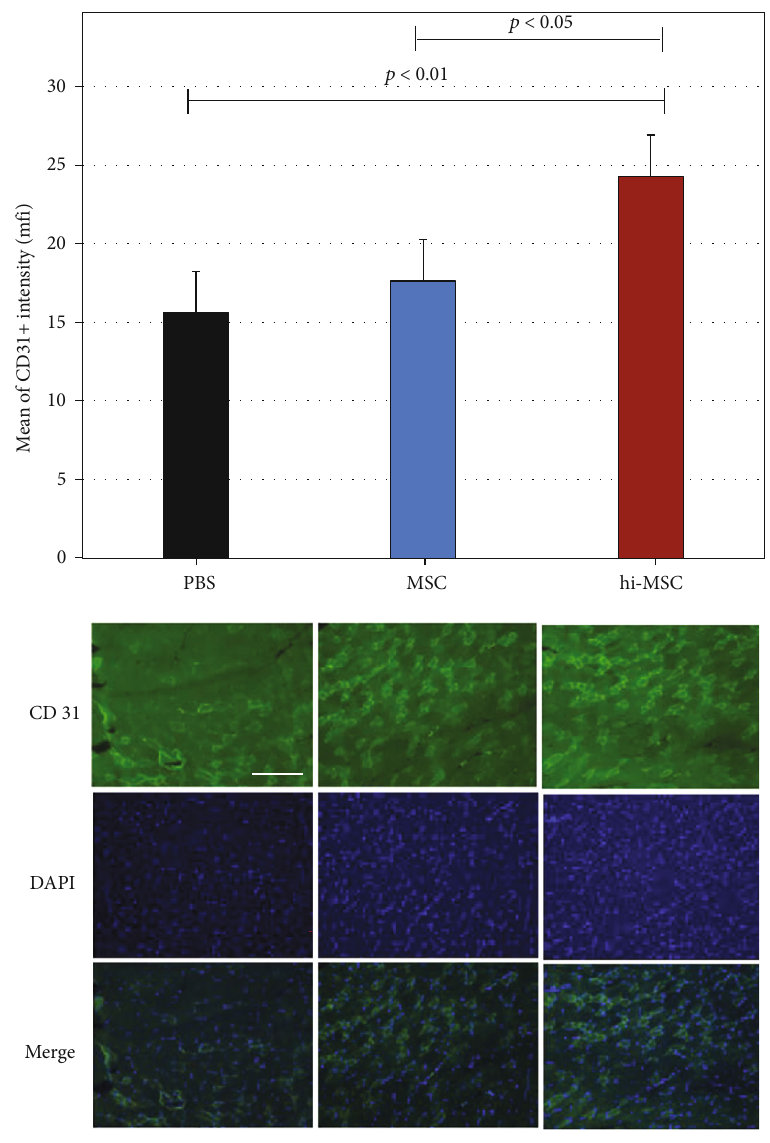
Figure 5: Mean cluster of di ff erentiation 31 (CD31) intensity at day 28 after surgical induction of ischemia. (a) Mean CD31 intensity in phosphate-bu ff ered saline (PBS; n = 6 ), mesenchymal stem cell (MSC; n = 6 ), and hypoxia-induced MSC (hi-MSC; n = 6 ) injection groups. (b) Representative images of CD31 immunostaining. Scale bar: 50 μ